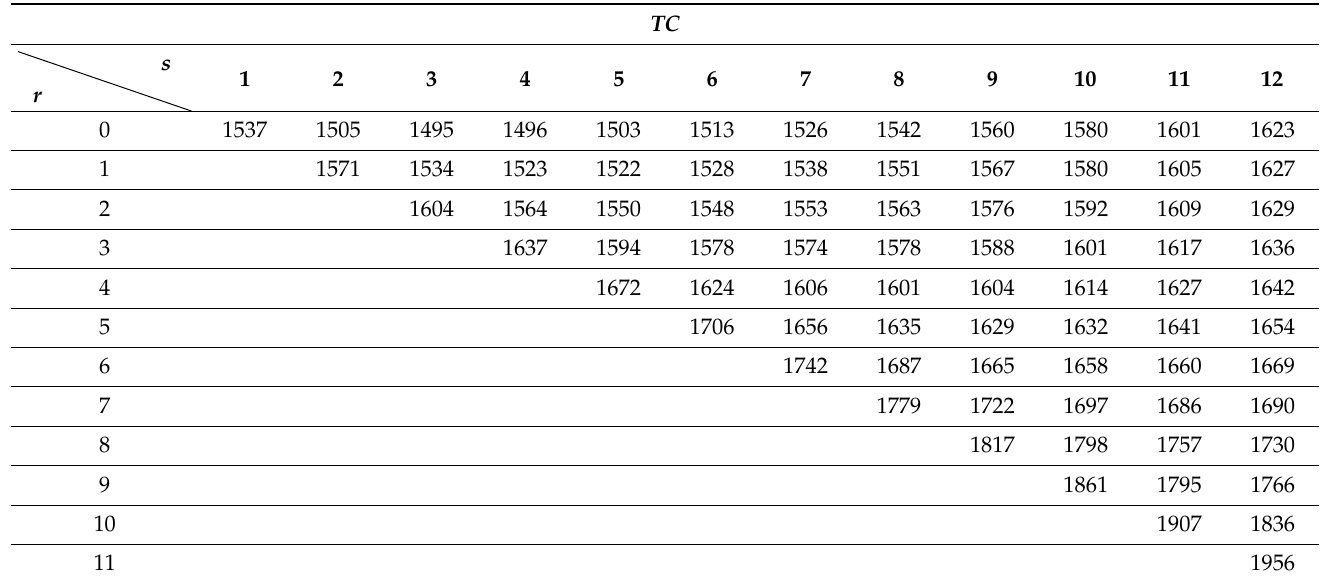
Table 10. Results of problem (23); λ = 20, µ 1 = 35, µ 2 = 25, κ = 2, ν 1 = 5, ν 2 = 10, τ = 20, φ 1 =